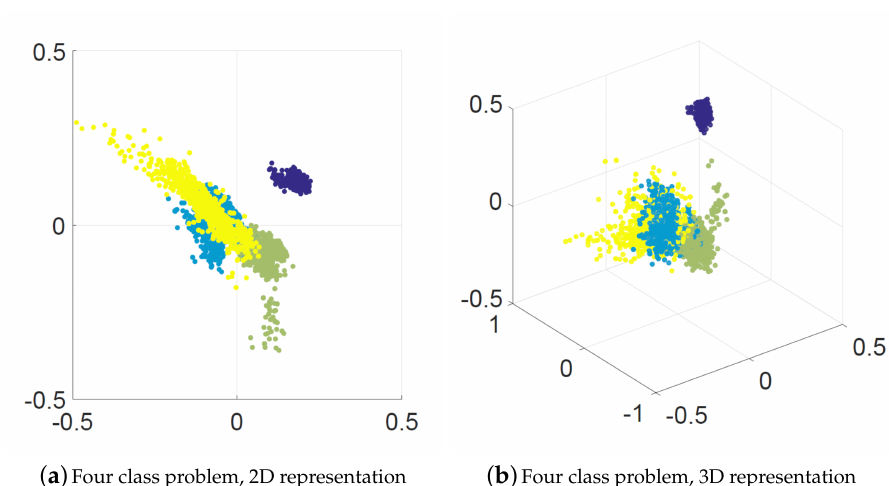
Figure 6. 2D and 3D centered kernel alignment (CKA)-based projection from SFS-based selected features (four-class